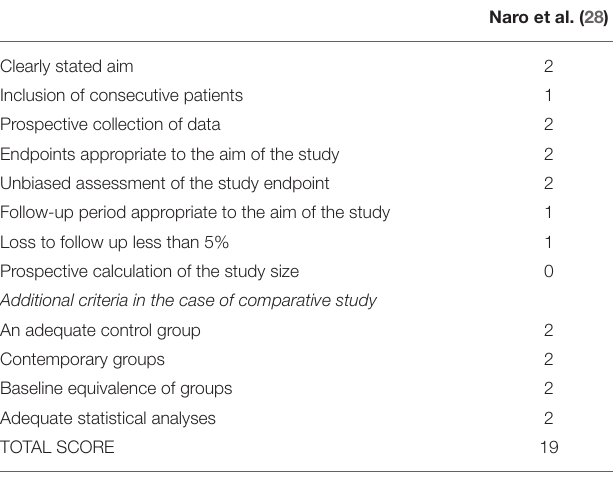
TABLE 6 | Individual MINORS score.